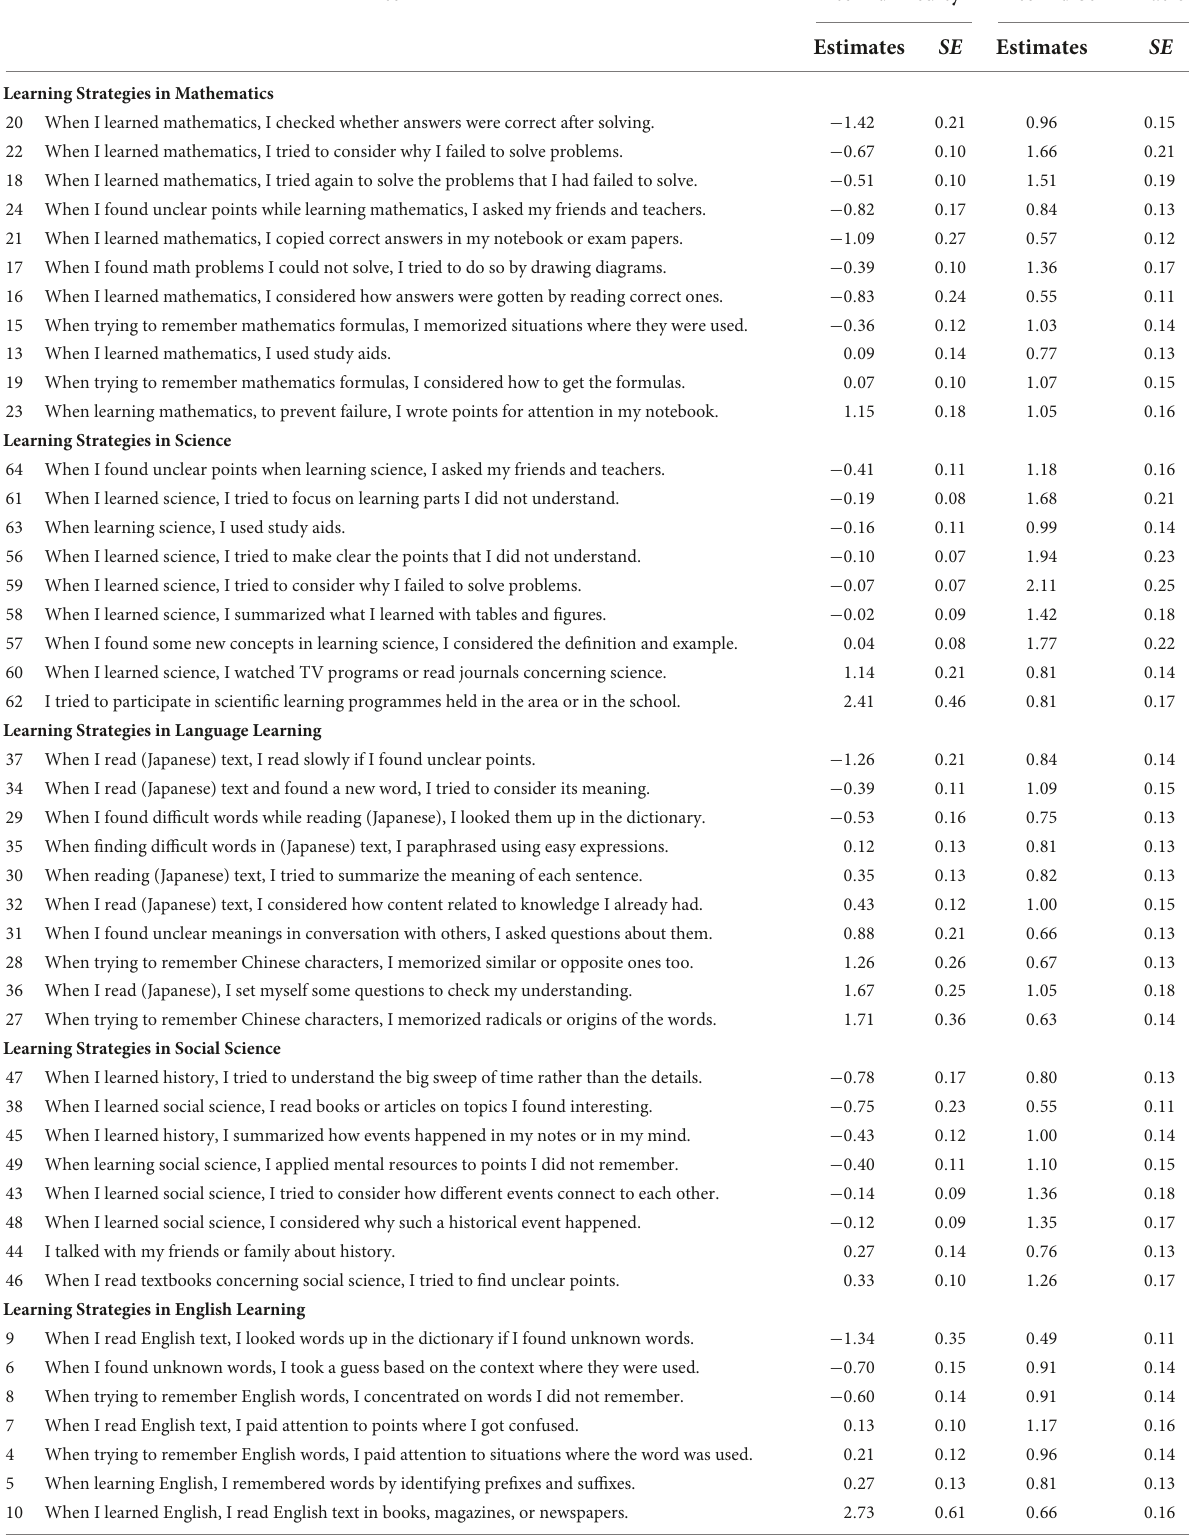
TABLE 4 Results of item response theory (IRT)